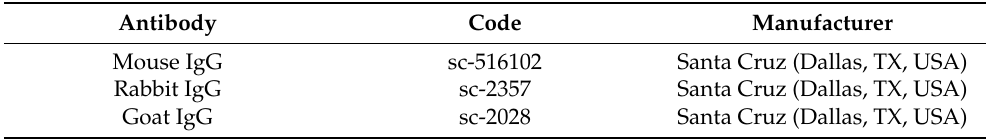
Table 2. Secondary antibodies for Western blot